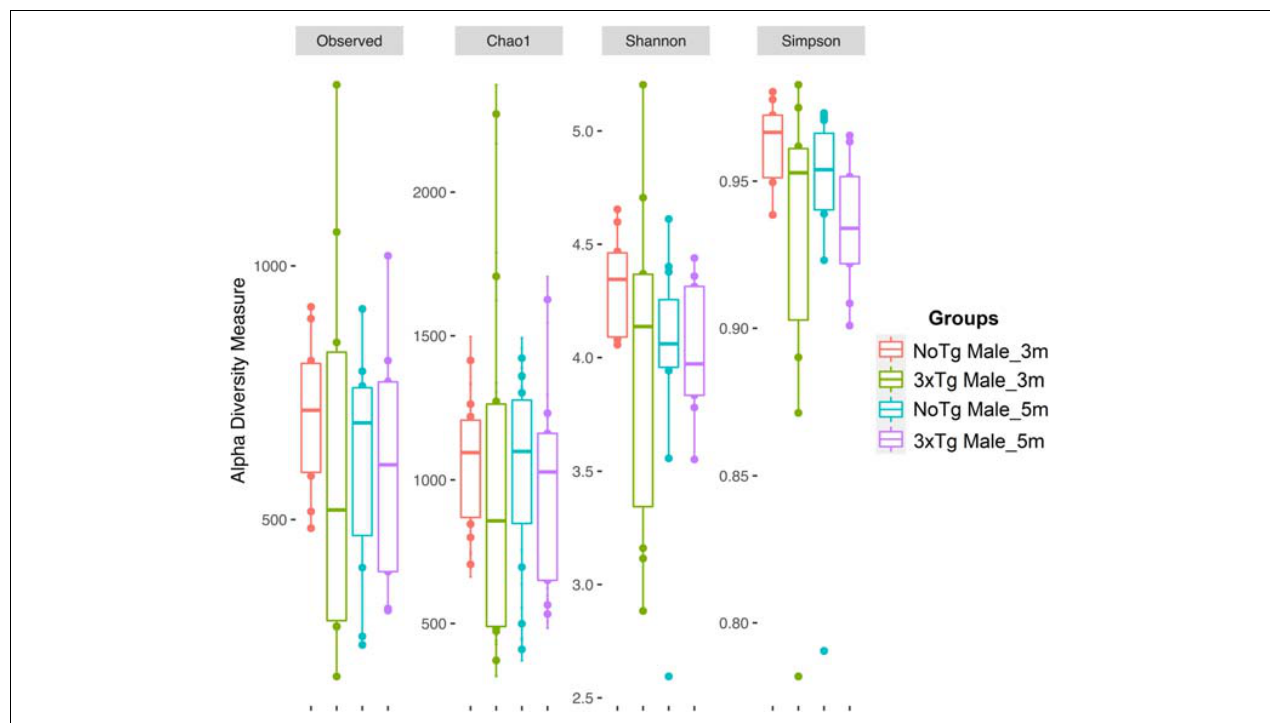
FIGURE 7 | Alpha diversity of bacteria in fecal samples collected from male mice. The figure shows data for non-transgenic (NoTg) (coral pink) and Alzheimer’s disease triple-transgenic (3xTg-AD) mice at 3 months (m) old (light olive) and NoTg (light blue) and 3xTg-AD mice at 5 months old (light purple). The Y -axis indicates the values for the corresponding indexes: observed number of species (Observed), expected bacterial richness (Chao1), and Shannon and Simpson diversity ( Supplementary Tables 3, 4